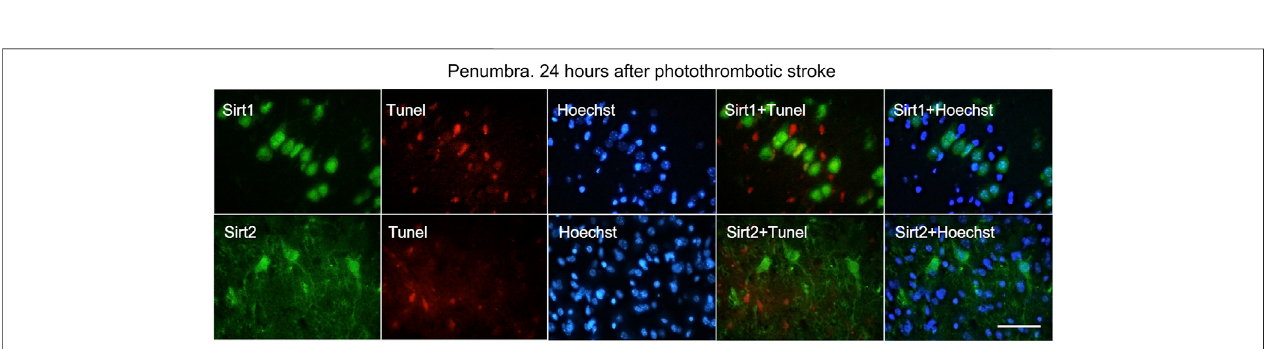
FIGURE7| Immuno fl uorescence ofSIRT1, SIRT2,TUNEL-positiveapoptotic cells, nuclear chromatin markerHoechst33342,andimageoverlay inthepenumbra 24 hafter photothrombotic stroke intheratcerebralcortex.Thescalebaris100 μ m.CellscontainingSIRT1 orSIRT2(green)donotco-localizewiththeTUNEL-positive apoptotic cells